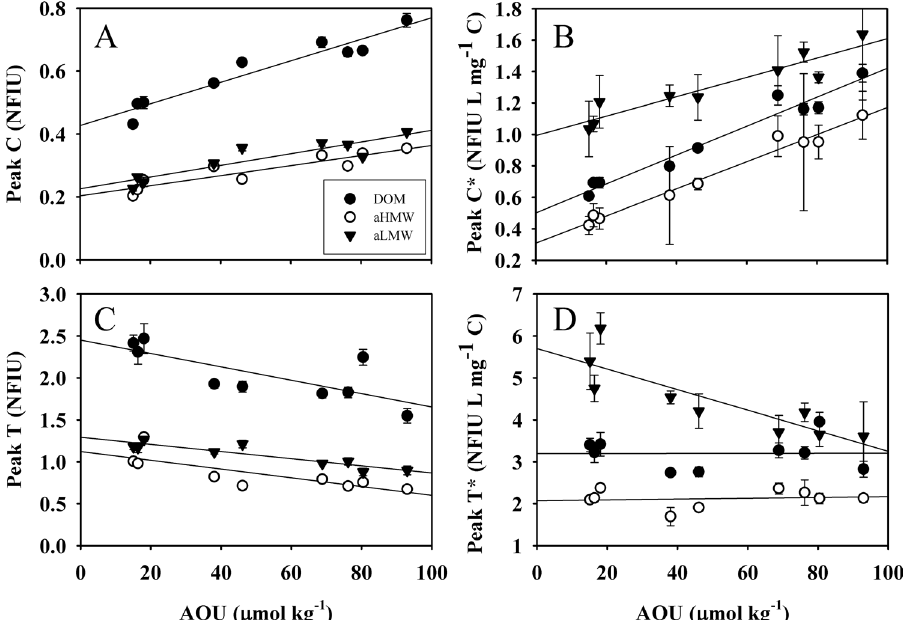
Figure 3. DOM size-fractionation with apparent oxygen utilization on a fluorescence basis. DOM (solid black circles), aHMW (open circles) and aLMW (solid black triangles) represent the bulk DOM, the apparent high molecular weight fraction and the apparent low molecular weight fractions, respectively, of samples collected along the core-of-flow of the Levantine Intermediate Water. ( A ) Humic-like fluorescence (peak C), ( B ) humic- like fluorescence per carbon unit (peak C * ), ( C ) protein-like fluorescence (peak T) and ( D ) protein-like fluorescence per carbon unit (peak T * ) with respect to apparent oxygen utilization (AOU). Error bars represent standard errors.